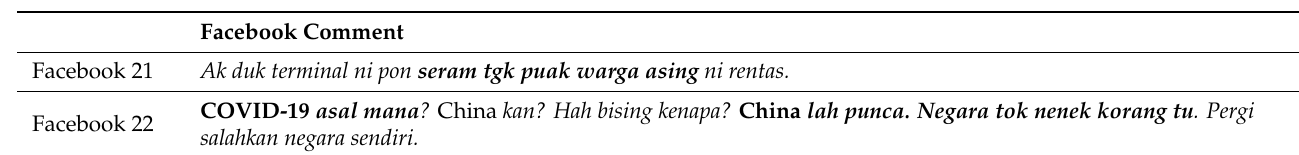
Table A2. Examples of ethnicity-related stigmatization of COVID-19 patients in Facebook comments (N =